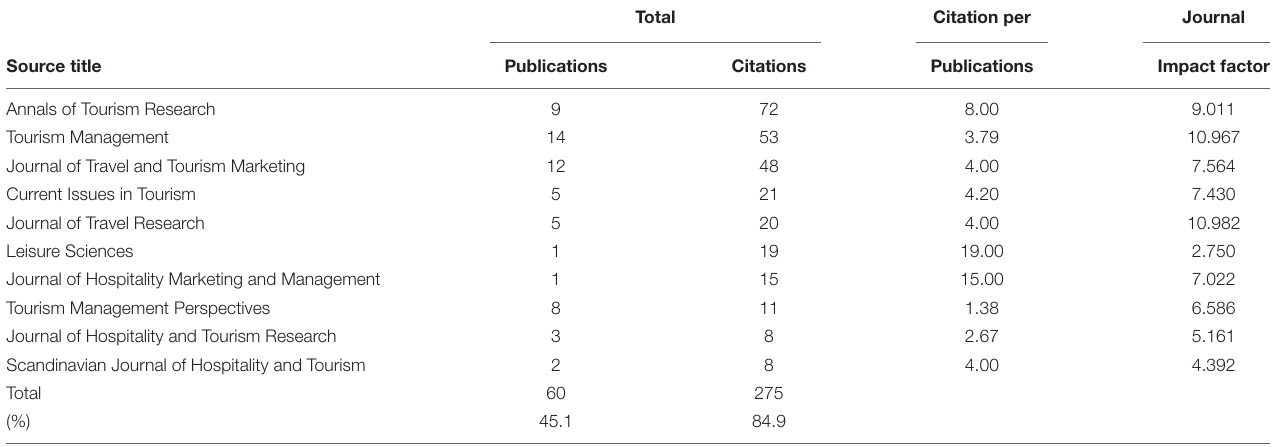
FIGURE 1 | Year-wise publication from Web of Sciences. TABLE 1 | Top Journals in family tourism